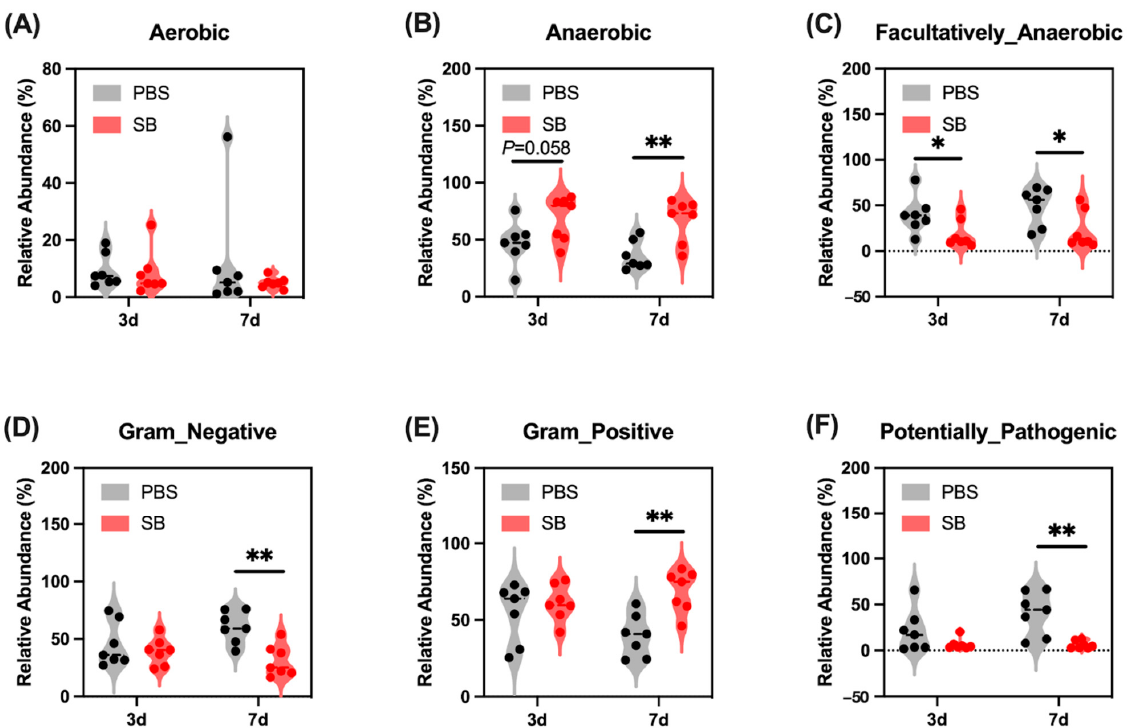
Figure 3. Effects of S. boulardii early intervention on the phenotype of the gut microbiome. BugBase analysis for Aerobic ( A ), Anaerobic ( B ), Facultatively_Anaerobic ( C ), Gram_Negative ( D ), Gram_Positive ( E ), and Potentially_Pathogenic ( F ). n = 7 * p < 0.05, ** p < 0.01. d, day. PBS, rats early intervened with phosphate buffer solution. SB, rats early intervened with S. boulardii .